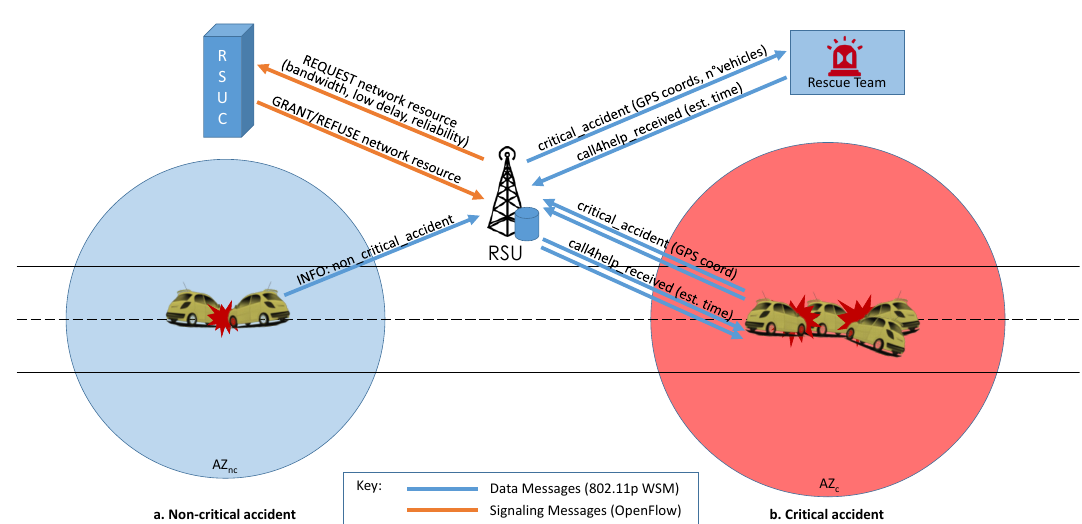
Figure 4. Emergency scenarios: ( a ) Non-critical accident: the vehicles start an AZ to disseminate local information about the moderate issue and optionally can send a Wave Short Message (WSM) notification to the RSU; ( b ) Critical accident: the vehicles involved create an AZ with a bigger radius than the non-critical case and notify the RSU about the entity of the accident, plus their location. In turn, the RSU sends OpenFlow messages to the RSUC to signal the need for more network resources, and waits for request approval or denial. At the same time, the RSU calculates the number of vehicles involved and sends an aggregated WSM request to the rescue service, which answers with the estimated arrival time that, in turn, will be forwarded to the vehicles